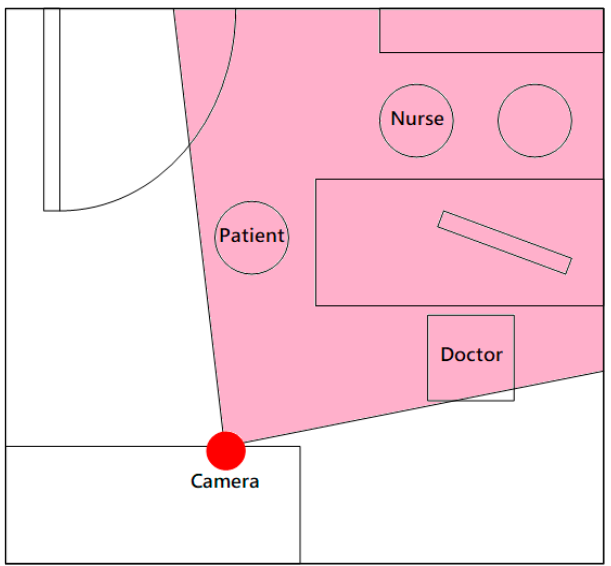
Figure 2. Video recorder’s positioning and view in the consultation room.